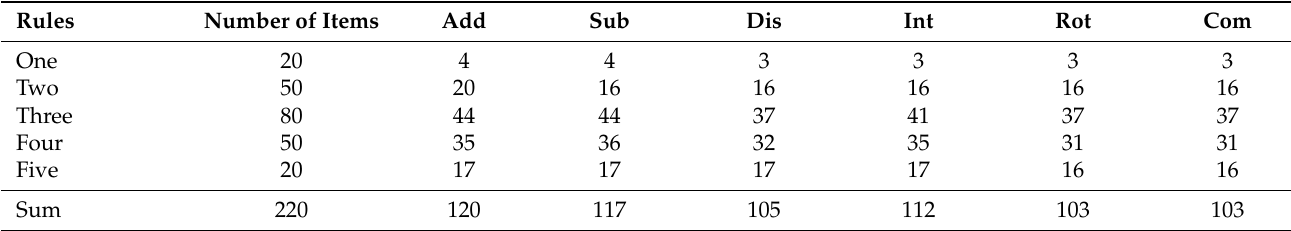
Table 1. Properties of the developed items.